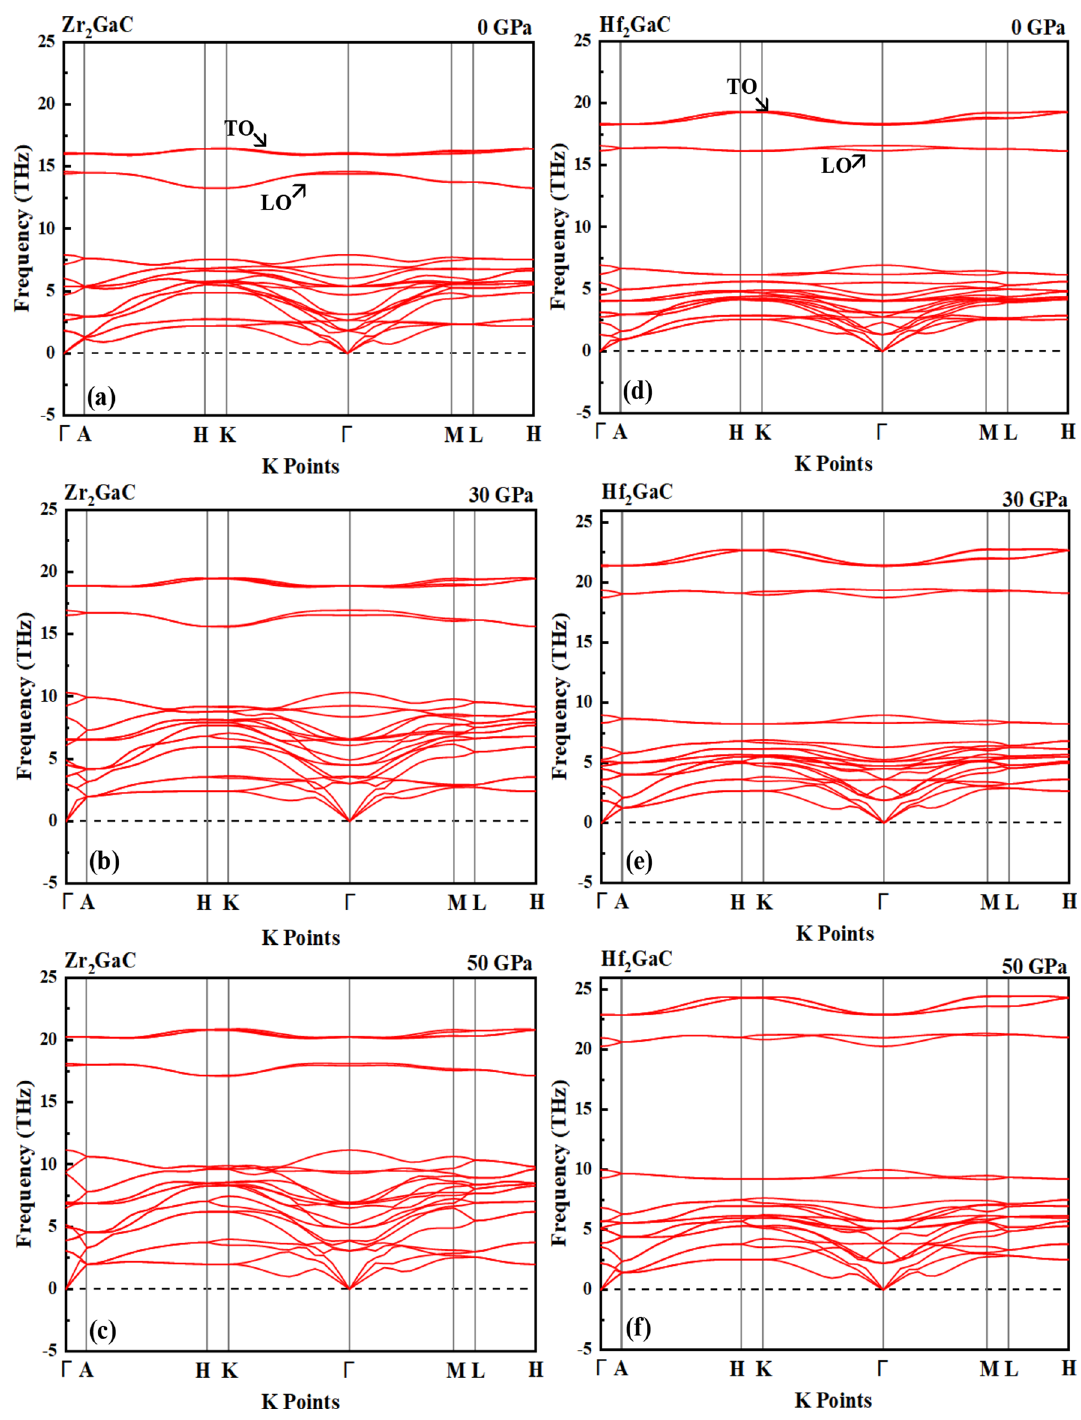
Figure 13. The phonon dispersion curve for Zr 2 GaC at pressure a 0 GPa, b 30 GPa, and c 50 GPa, and for Hf 2 GaC at pressure d 0 GPa, e 30 GPa, and f 50